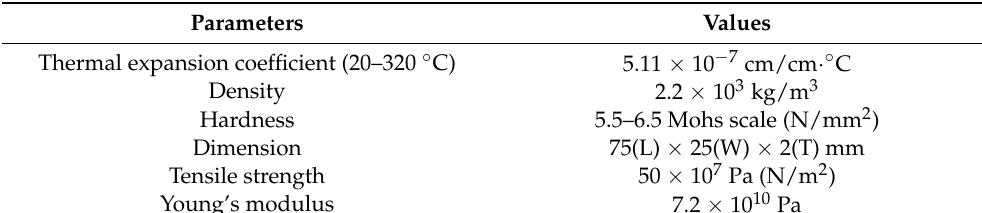
Table 2. Selected properties of quartz glass [20].